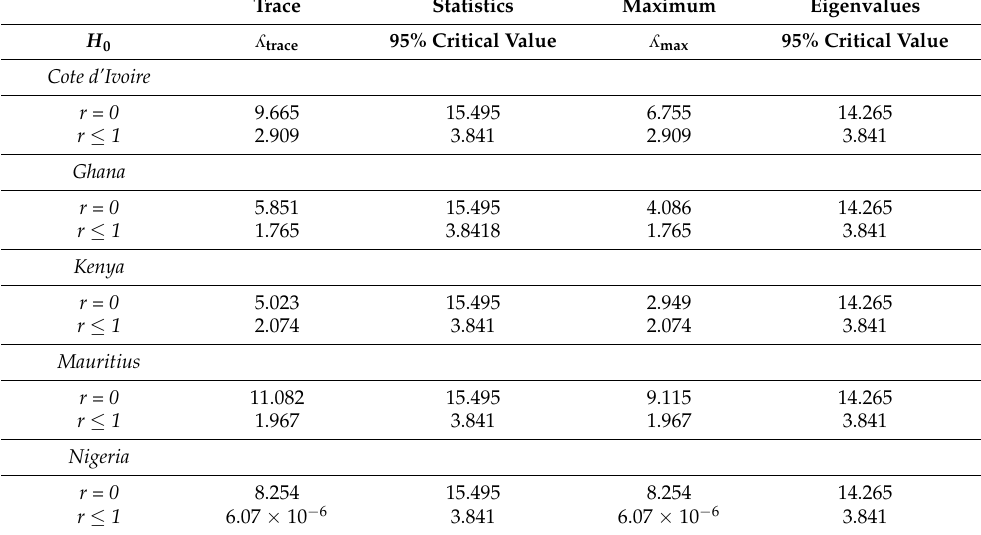
Table 4. Long-run cointegration test.